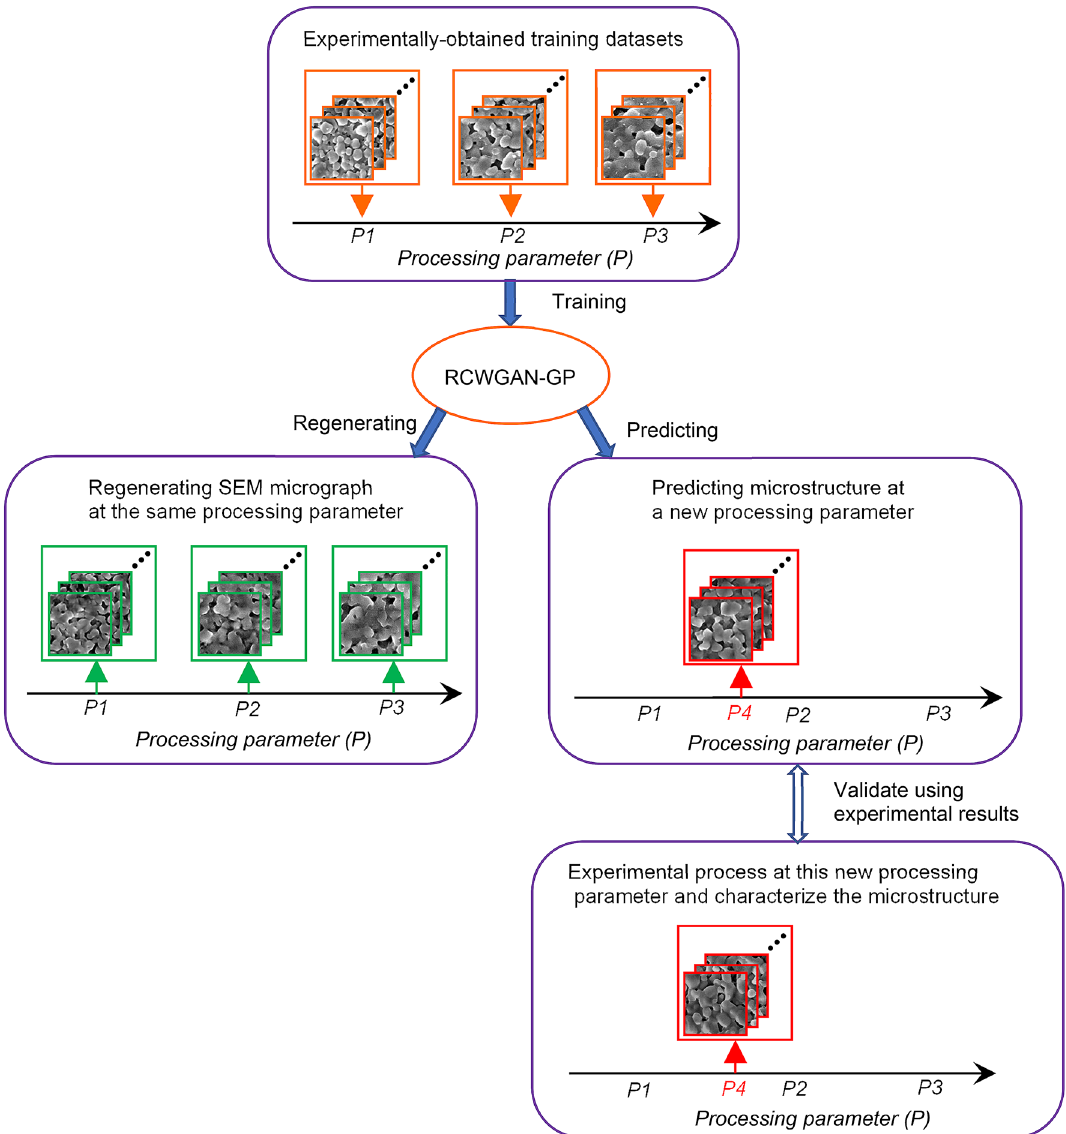
Figure 1. The approach of evaluating RCWGAN-GP for predicting the microstructure of laser-sintered alumina under a new laser